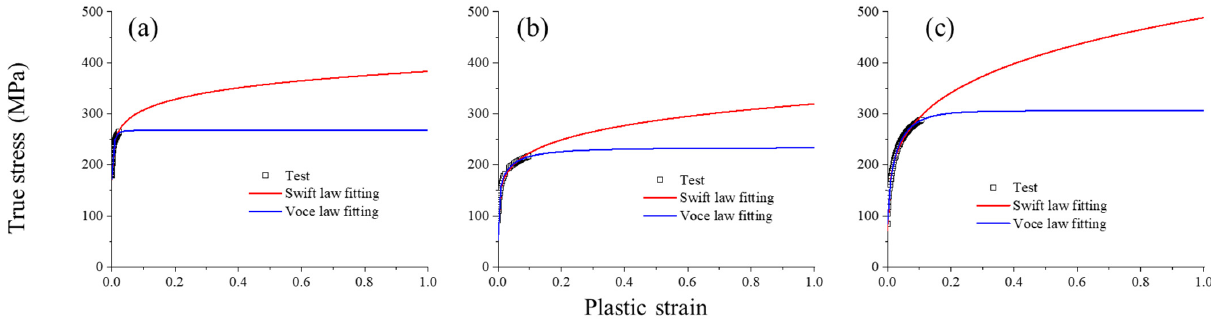
Figure 5. True stress–plastic strain curves and hardening-law fittings before necking: ( a ) MAT 1, ( b ) MAT 2, and ( c ) MAT 3.